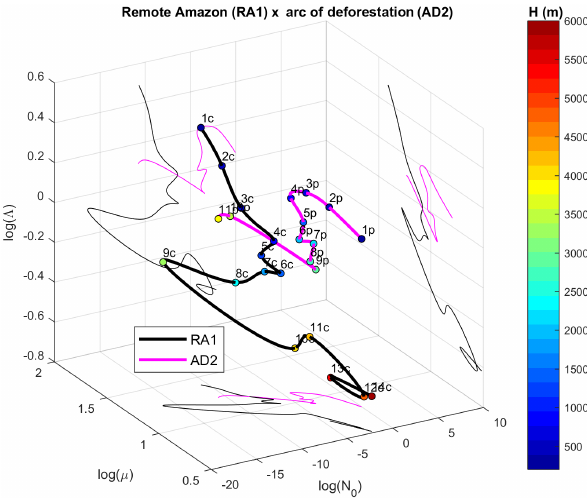
Figure 8. Observed trajectories for the clouds measured over the remote Amazon during flight RA1 (continuous line) and over the arc of deforestation during flight AD2 (dashed line). The numbers shown close to the observed trajectories start at 1 at cloud base and grow with altitude (the respective markers are colored according to altitude above cloud base, H ). Their respective properties are presented in Tables 2 and